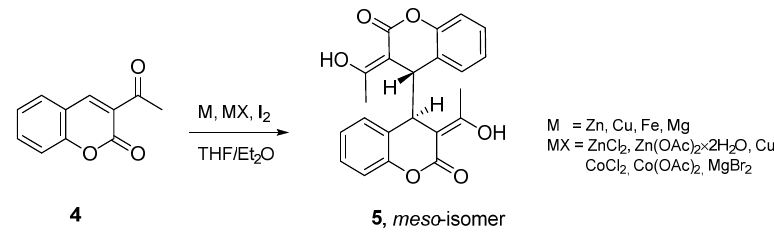
Scheme 4. Initiation of the reaction by different metals and metal salts. Table 3. Evaluating the combination metal and metal salts as new conditions for the homodimerization reaction.